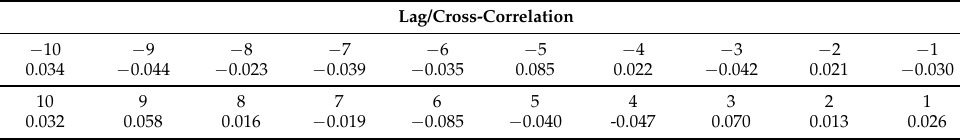
Figure 16. Cross-correlation between variations in daily topics and value. Table 6. Values in the lag window (variations in daily topics and